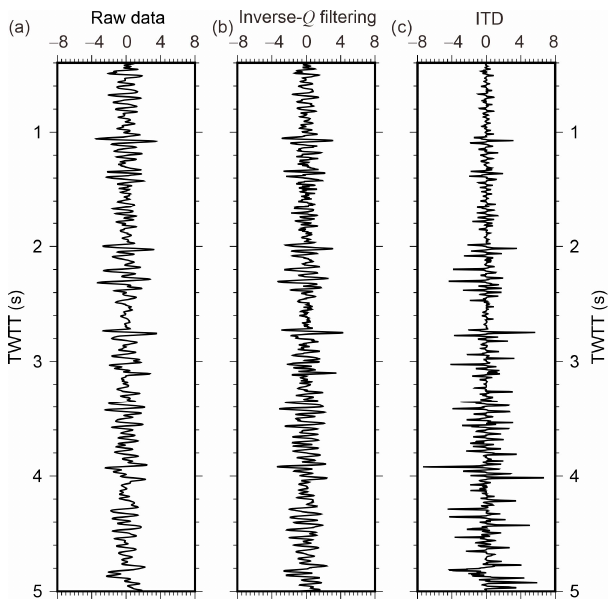
Figure 12. Record at CMP = 200 in Figure 11: ( a ) field data before Q -compensation, ( b ) after com- pensation by using stabilized inverse- Q filtering, and ( c ) Q -compensation by using ITD. For plot- ting, all records were normalized by the root-mean-square amplitudes.